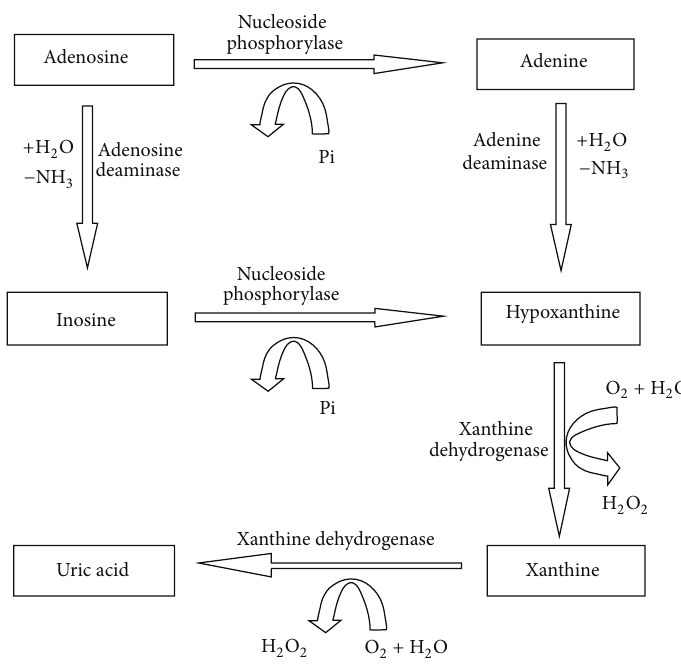
Figure 1: The related purine metabolic